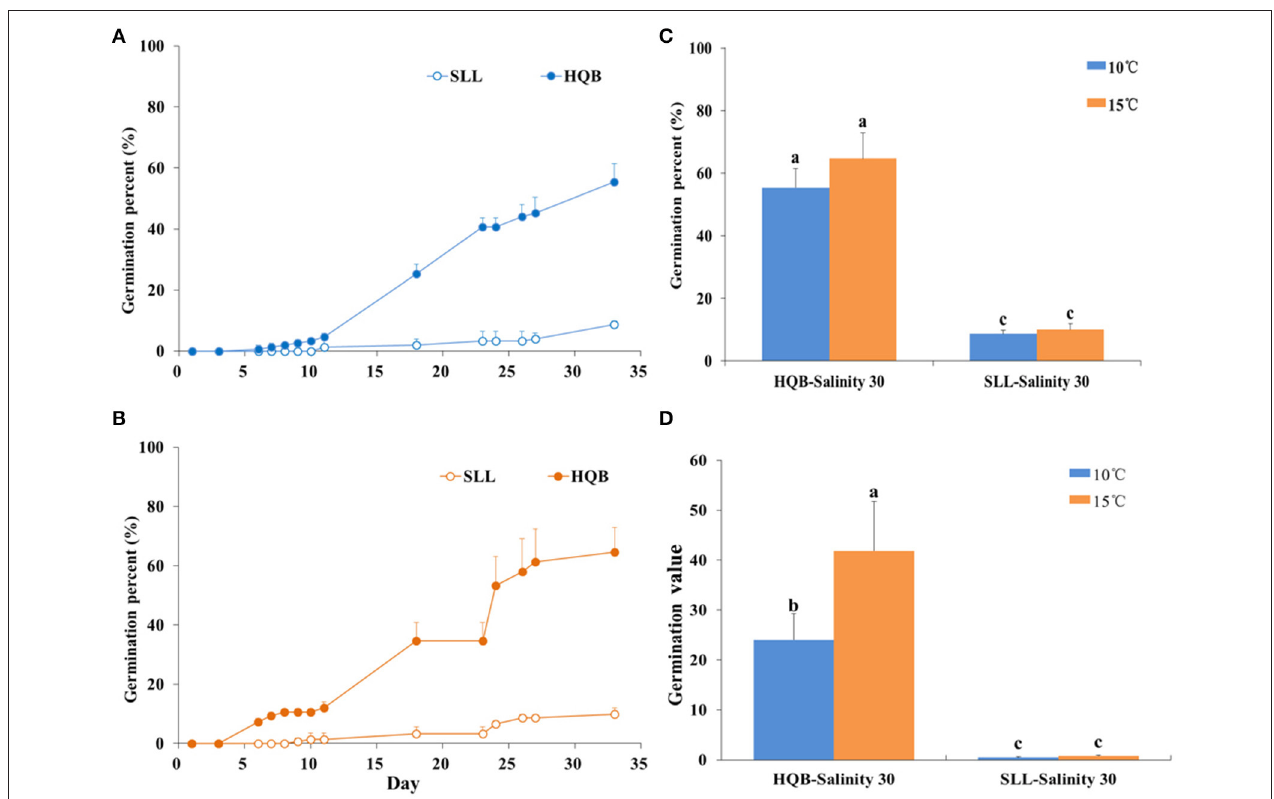
FIGURE 10 | Comparison of the germination percent (GP) and germination value (GV(D)) of Zostera marina seeds from different sources, Swan Lake (SLL) and Huiquan Bay (HQB), subjected to two temperatures (10 and 15 ◦ C). (A,B) GP at 10 and 15 ◦ C, respectively; (C,D) GP and GV(D) after 4 weeks, respectively. Values are means ± sd . Different lowercase letters (a,b) in (C) and (D) denote significant differences ( p <